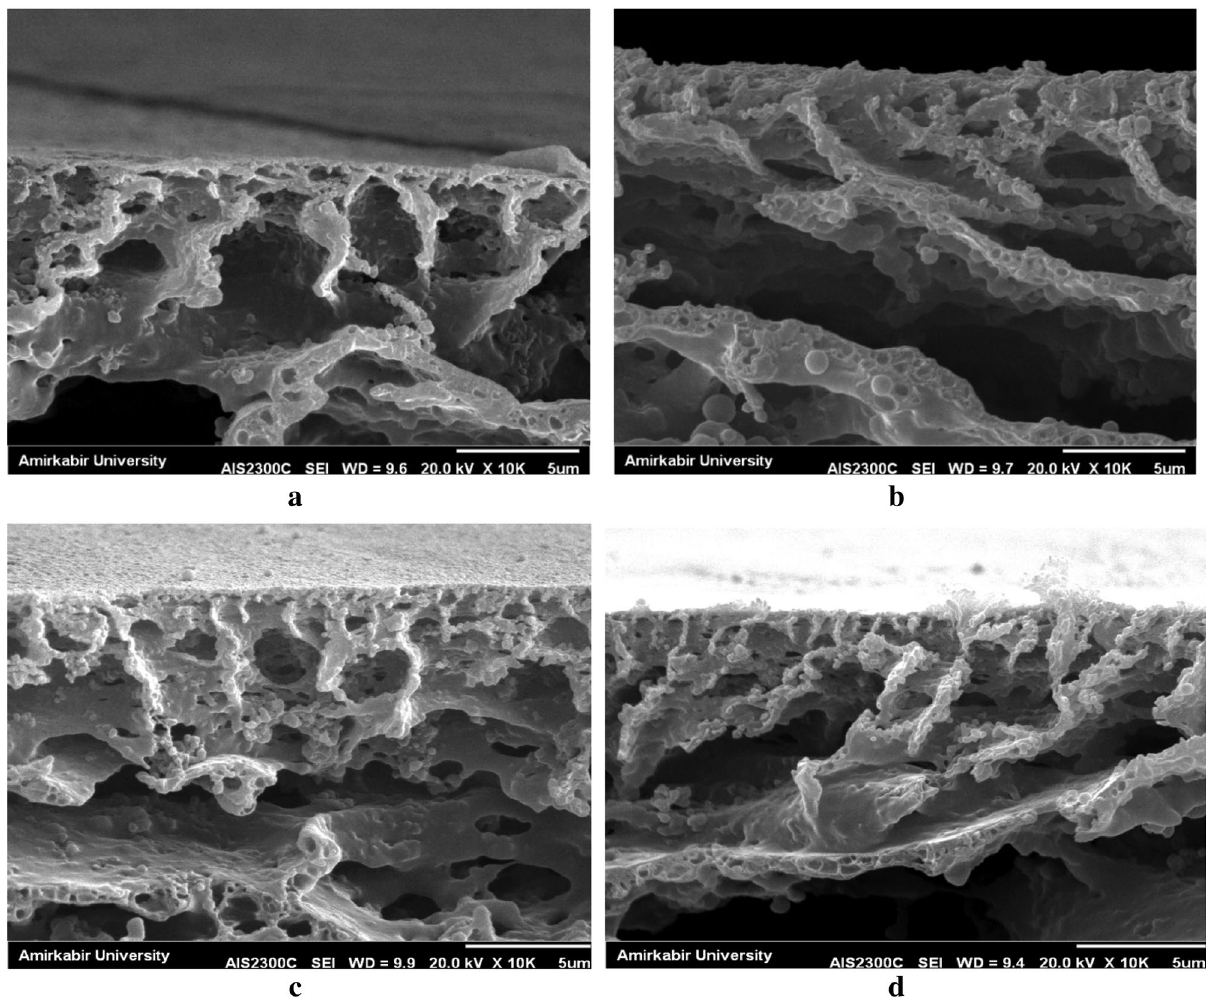
Figure 4. The cross-section SEM images of ( a ) SAN 25/NMP, ( b ) SAN 25/DMF, ( c ) SAN 30/NMP and ( d ) SAN 30/DMF as solvent, polymer concentration = 8%; Temperature = 30 °C, BWB time = 300 s, Casting